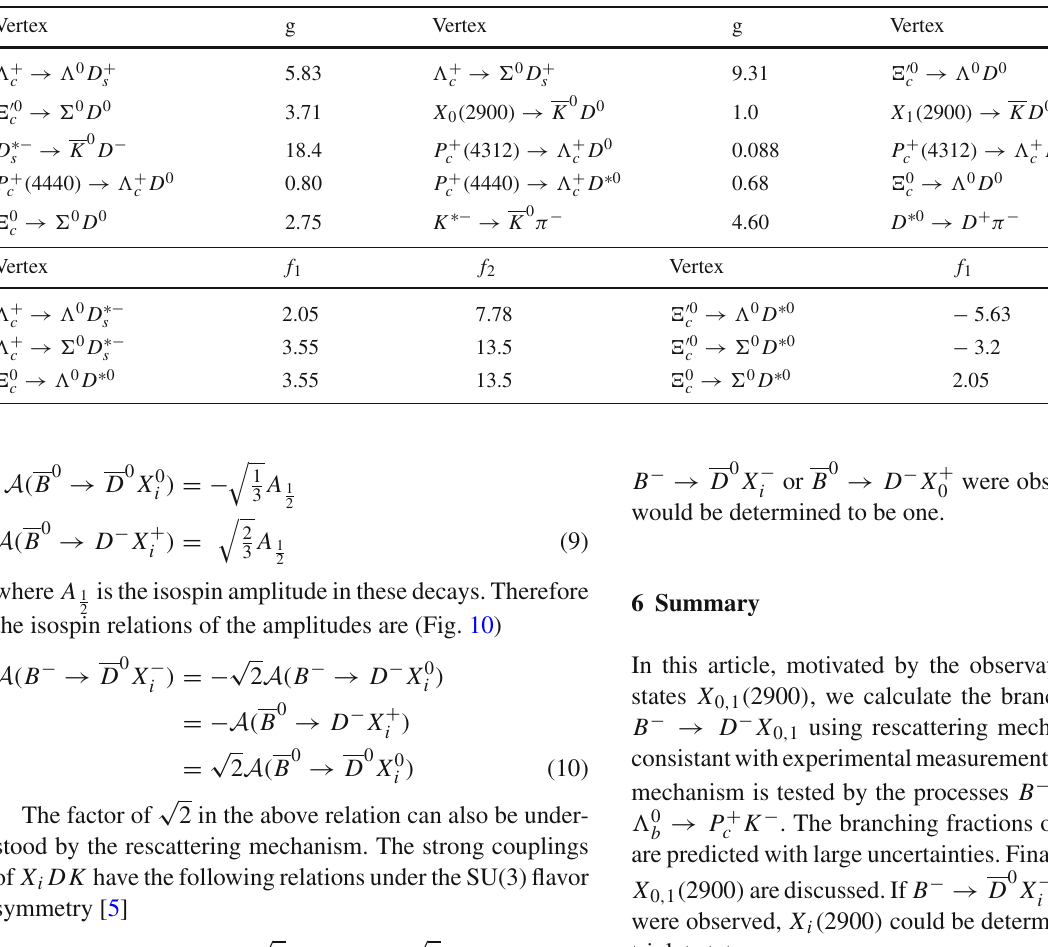
Table 2 The strong coupling